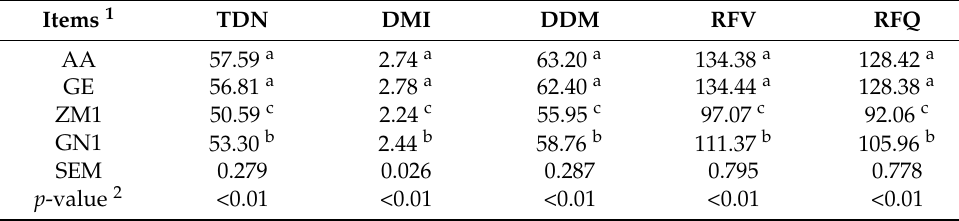
Table 8. Evaluation of feed value from various alfalfa hay cultivars